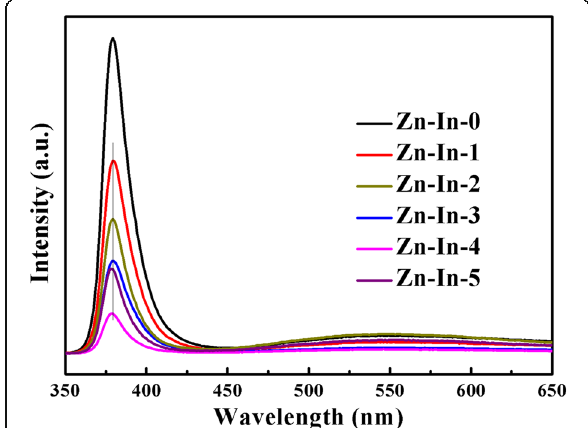
Fig. 6 PL spectra of ZnO/In 2 O 3 composites with different In 2 O 3 amount